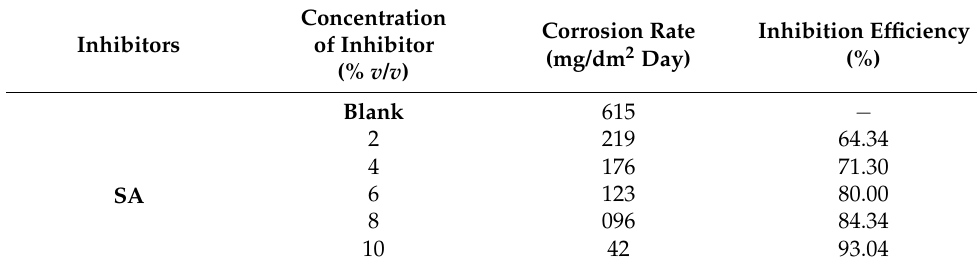
Table 3. Inhibition efficiency of aqueous leaves extract of SA on the corrosion of mild steel in 1.0 M HCl at room temperature (303